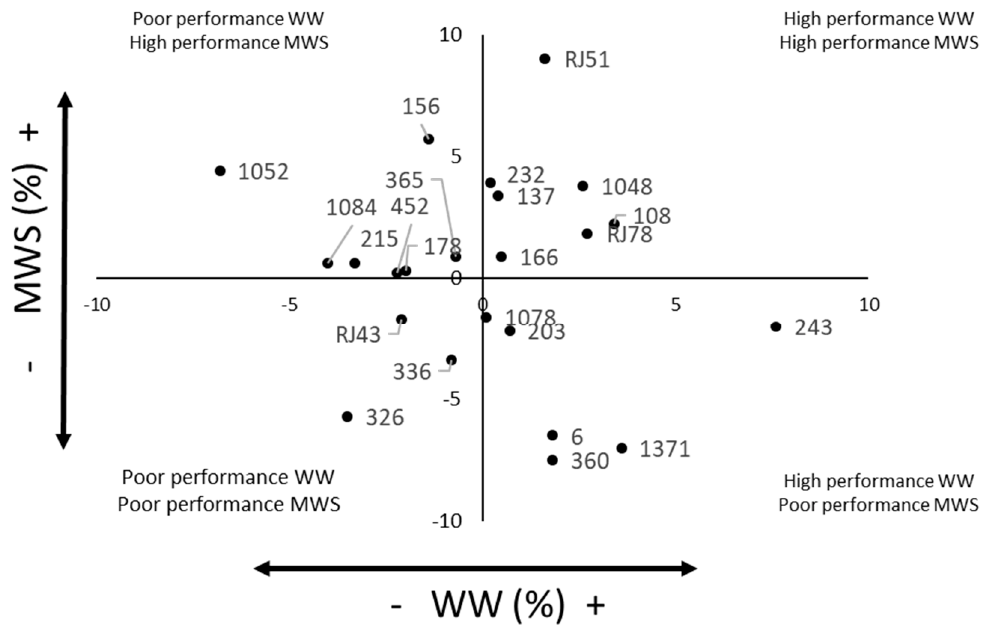
Figure 5. Residuals of the general WUE i over g s model expressed in terms of percentage for every genotype in WW (axis X) and MWS (axis Y) (See M&M section). Values are the mean (n = 10) of the two experimental years.